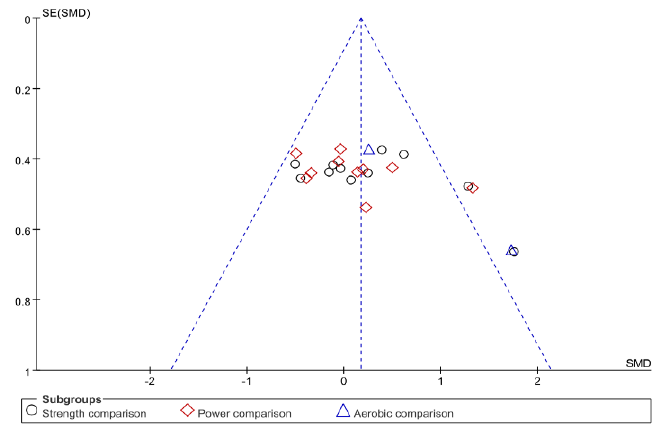
Figure 1. Funnel plots of standardized mean differences effect size versus standard error.